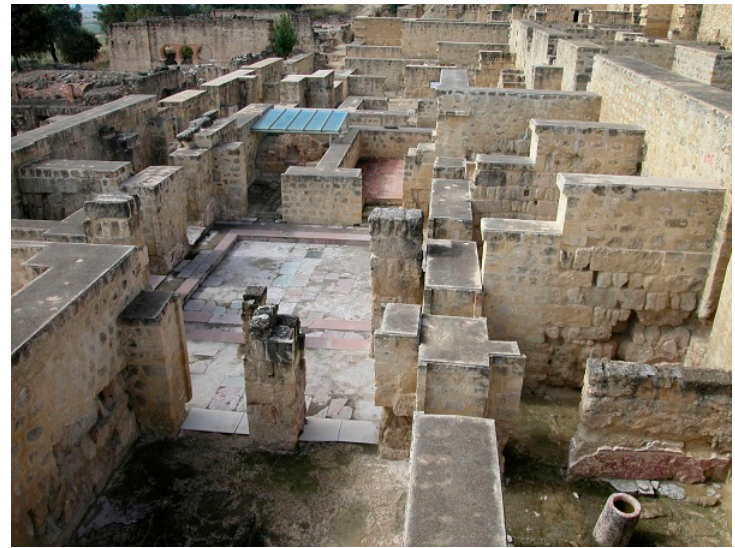
Figure 15. Eastern Service House, No. 12 (© Conjunto Arqueológico de Madinat al-Zahra).